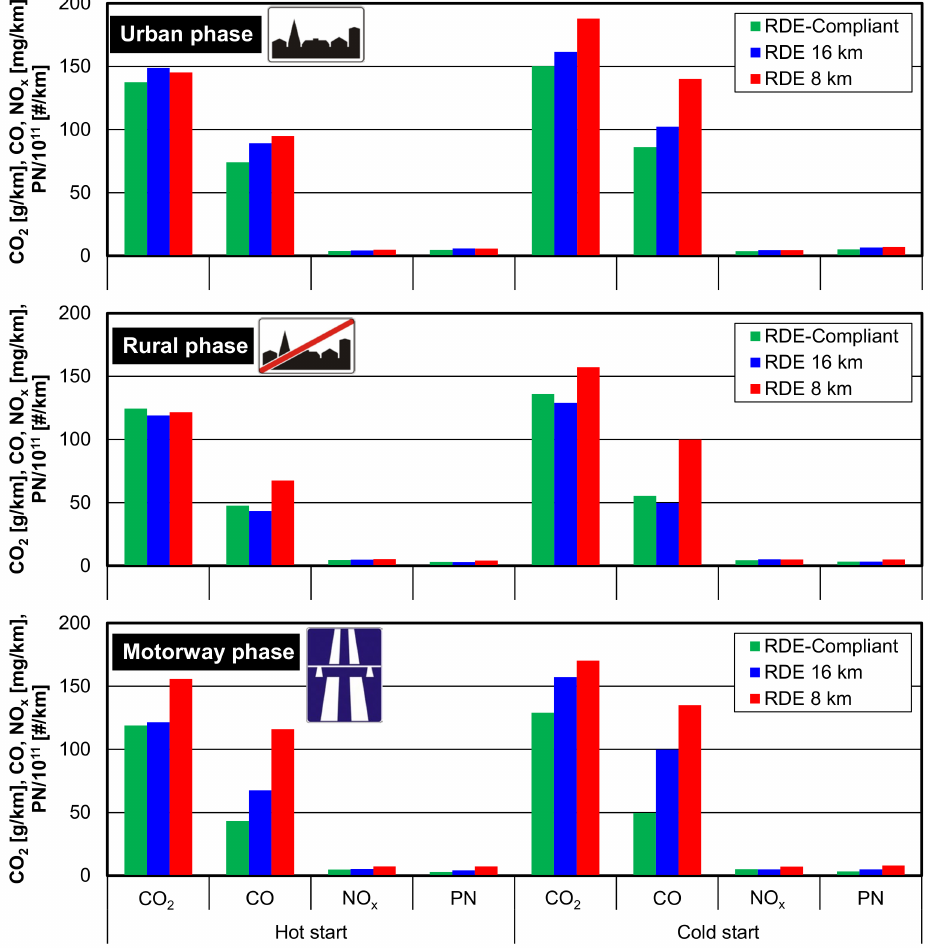
Figure 8. Road emissions (average values) of pollutants for cold and hot start in the urban, rural and motorway parts of the RDE-Compliant, RDE 16 km and RDE 8 km